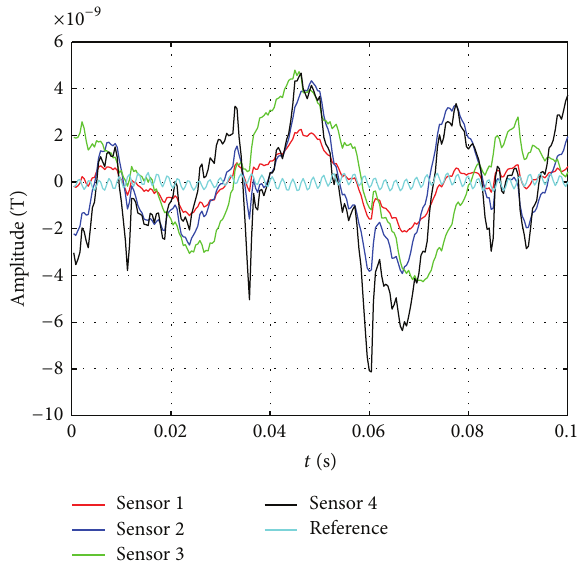
Figure 4: Time-domain waveforms of the received signals (three noise sources).